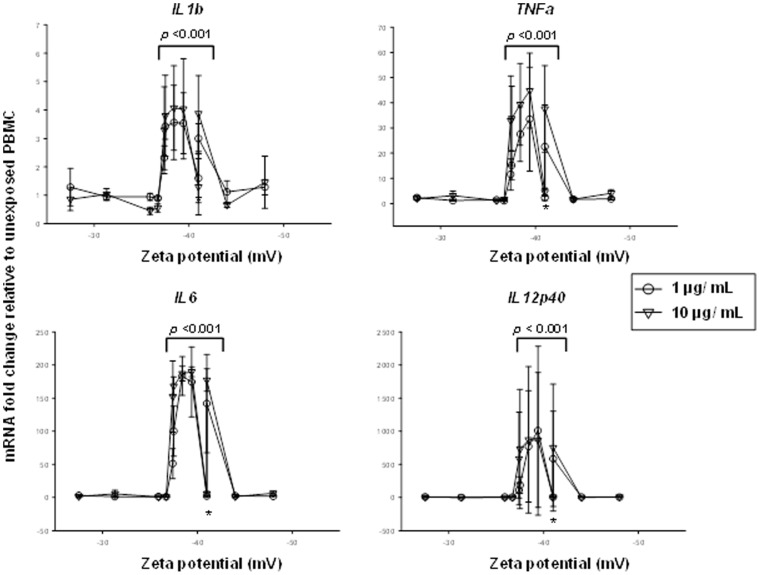
Effect of Charge (Zeta Potential) of DEP and DEP-Env Particles on the Bioreactivity of Human PBMC.
IL1b, TNFa, IL6, and IL12p40 mRNA fold changes (y-axes) in PBMC (from n = 3 donors) shown in 
Figure 3
 are plotted here as a function of mean zeta potential in millivolt (x-axes). All particles with zeta potentials from −37 to −41 mV, with one exception (asterisk *), showed significantly higher bioreactivity (p<0.001) compared to the particles below or above this size range.